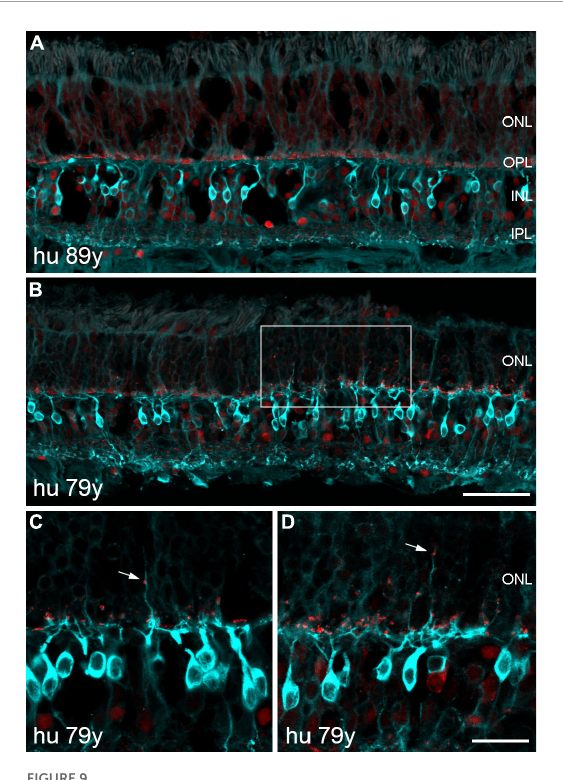
FIGURE9 Confocal images of human retina from two old donors double labeled for PKC α (cyan) and CtBP2 (red). (A) Section of peripheral retina from an 89-year-old donor displaying normal morphology of rod bipolar cells and photoreceptor synapses. (B) Section of peripheral retina from a 79-year-old donor demonstrating outgrowing dendrites and ectopic synapses within a small area of the ONL (framed). (C,D) Two additional sections showing outgrowing dendrites and ectopic synapses (arrows) at higher magnification. Scale bars, (A,B) 50 µ m and (C,D) 20 µ